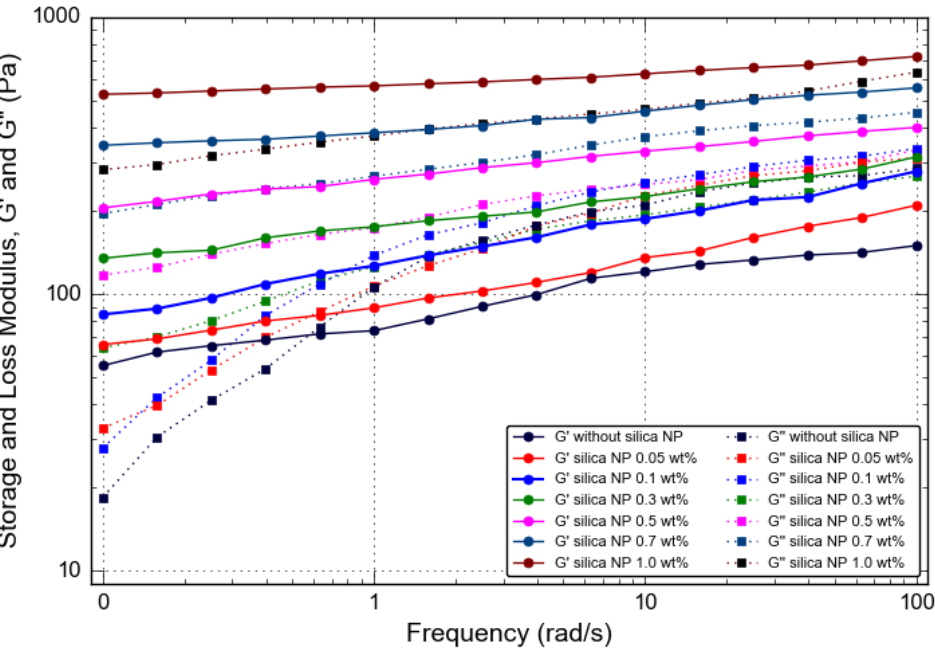
Figure 9. Storage and loss modulus, G ′ and G ″ , as a function of frequency for PAM/PEI polymer gel with different concentrations of silica NP.